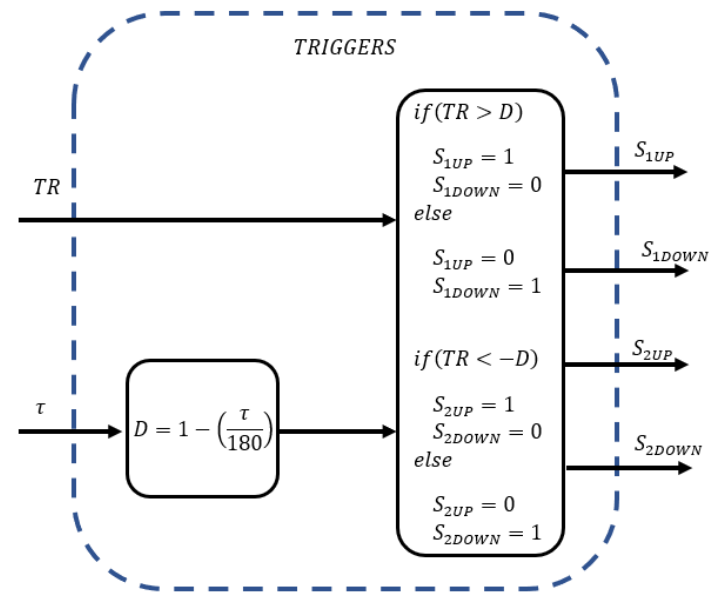
Figure 10. Trigger full bridge in function of inner phase shift τ .